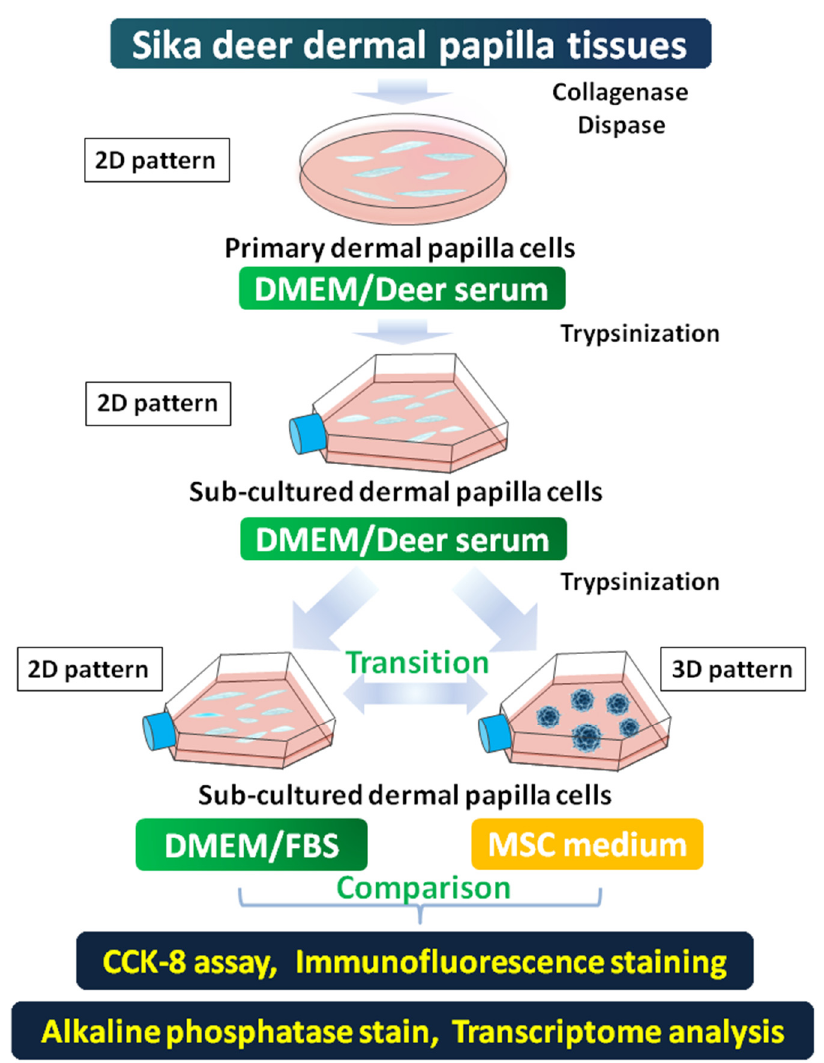
Figure 5. A schematic visualized the establishment of different DP cell growth patterns and the following analysis following analysis procedures.